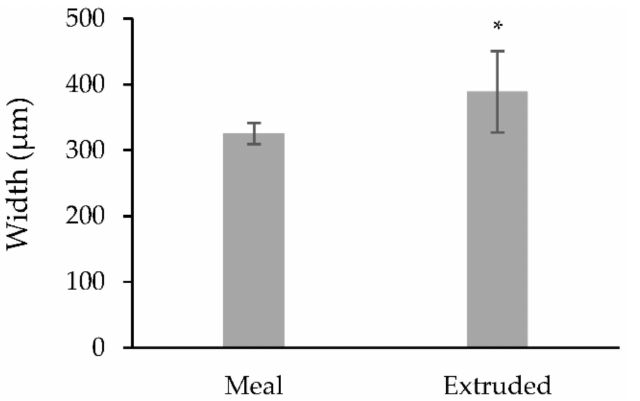
Figure 6. Average width of rumen papillae under different treatments ( µ m). * Represents significant differences between means ( p =